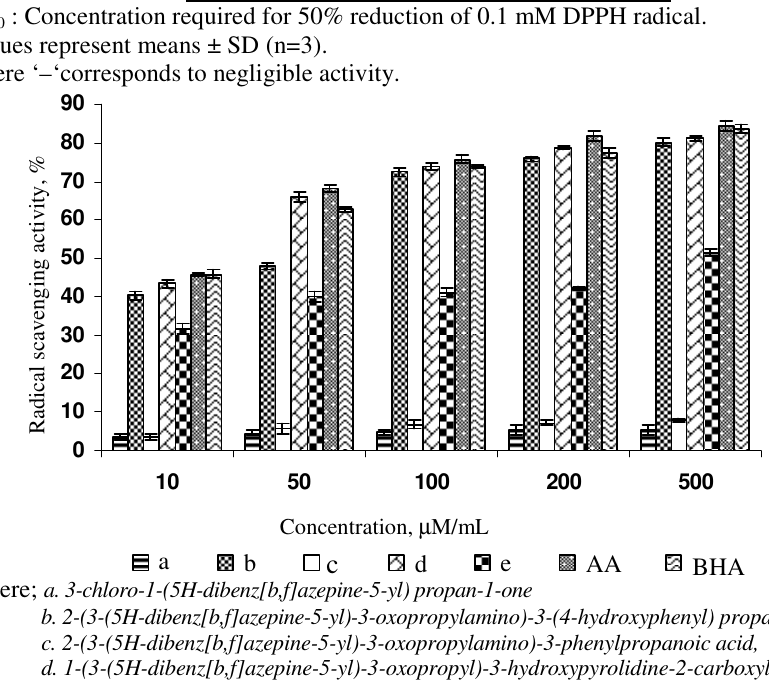
IC : Concentration required for 50% reduction of 0.1 mM DPPH radical. 50 Values represent means ± SD (n=3).